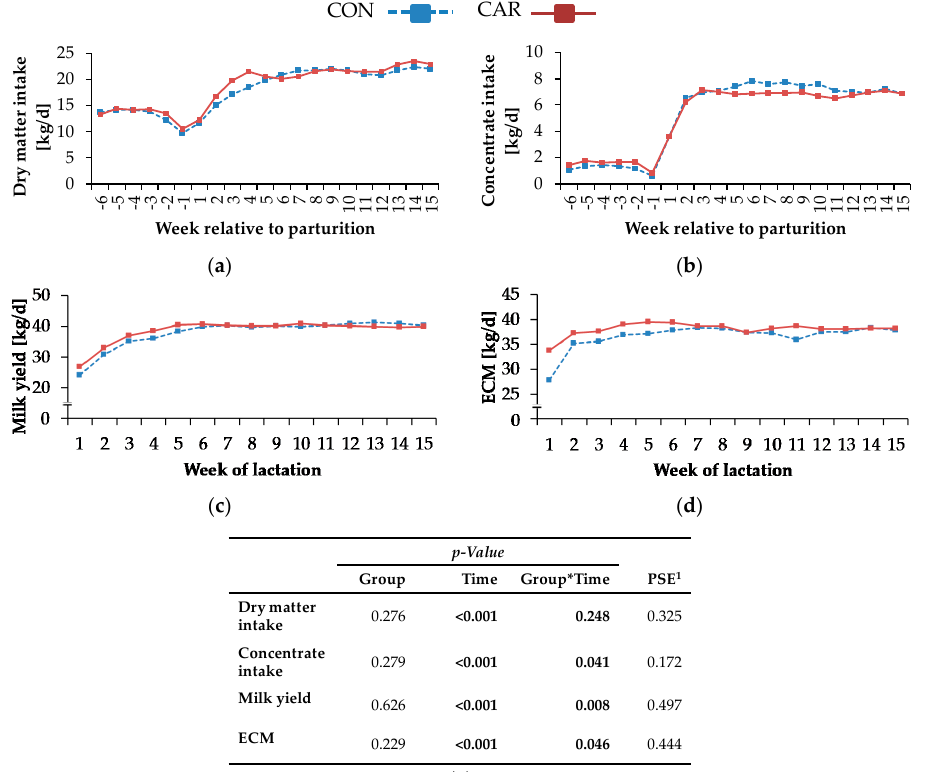
Figure 1. ( a ) Dry matter intake, ( b ) concentrate intake, ( c ) milk yield and ( d ) energy-corrected milk (ECM) of cows fed a non-supplemented (control, CON) or an L-carnitine-supplemented diet (25 g / d from 6 weeks ap up to week 15 pp , CAR). ( e ) Data statistics. Data are given as Least Square